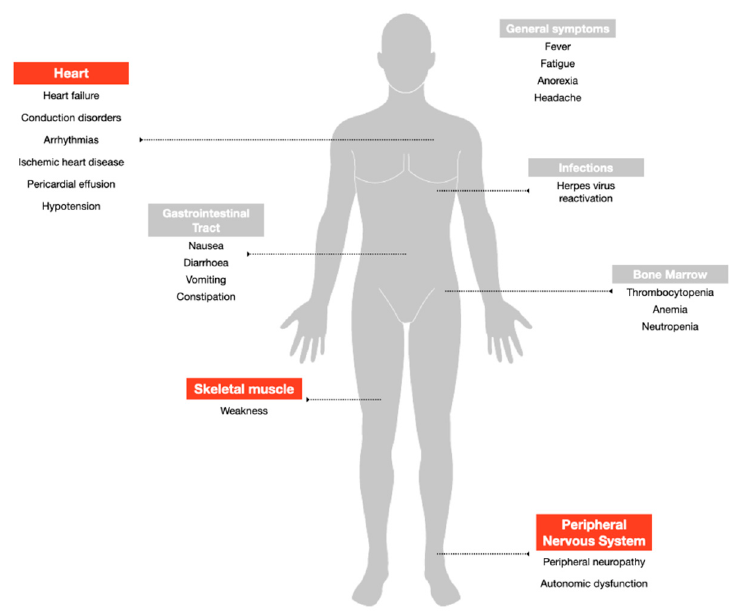
Figure 2. Adverse events associated with bortezomib treatment. Highlighted in red the side effects addressed in the review.